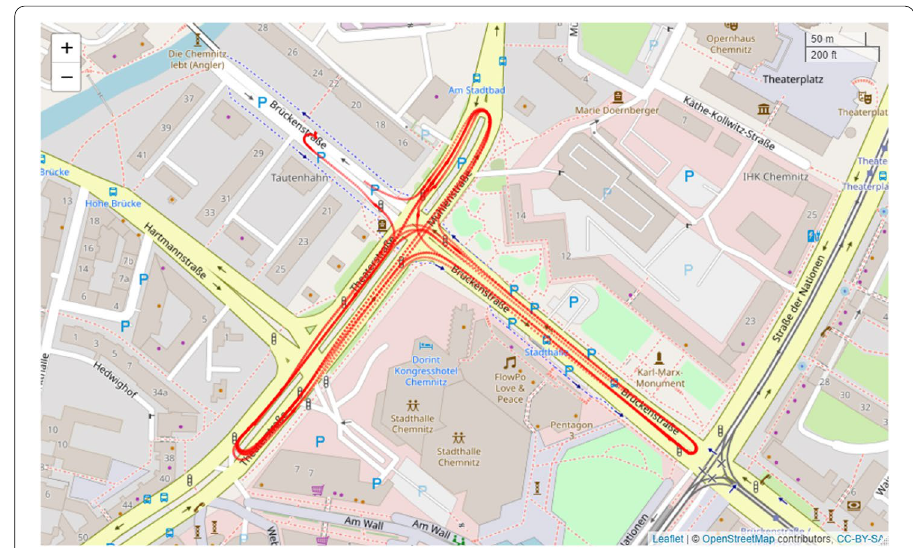
Fig. 4 Chemnitz City urban environment and ground